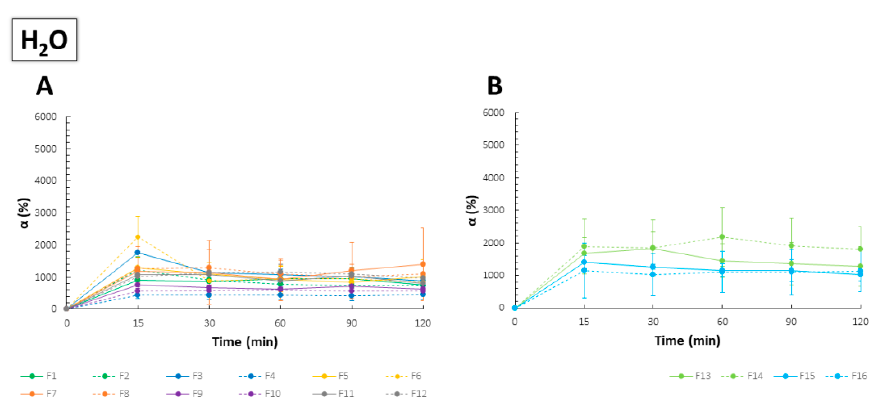
Figure 5. Swelling behavior of F1–F12 ( A ) and F13–F16 ( B ) films in purified water (mean ± SD, n =